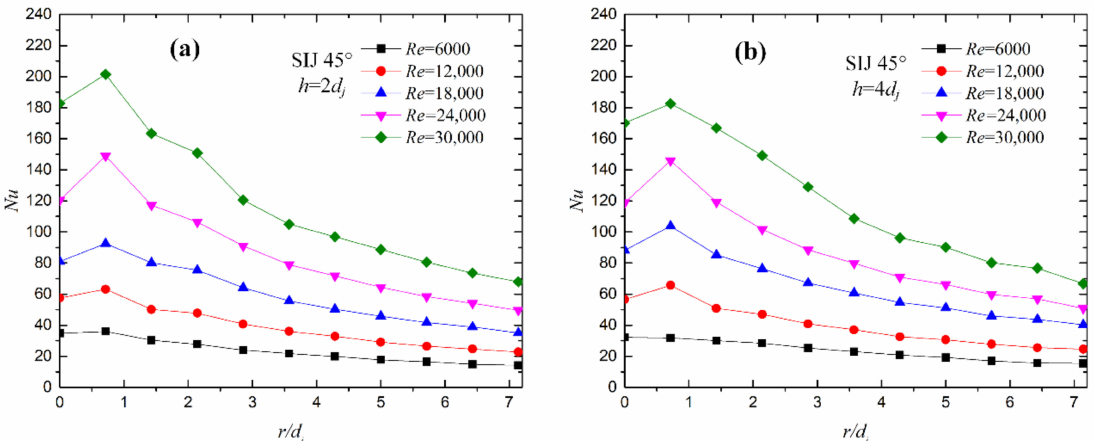
Figure 14. Experimental values of Nu distribution with different Re : ( a ) h = 2 d j and ( b ) h = 4 d j .